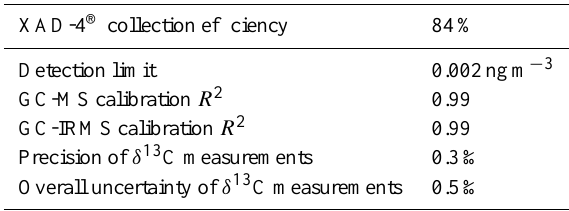
Table 1. Summary of performance characteristics of the sampling, extraction and analysis method of nitrophenols in PM and in the gas phase + PM (Saccon et al.,